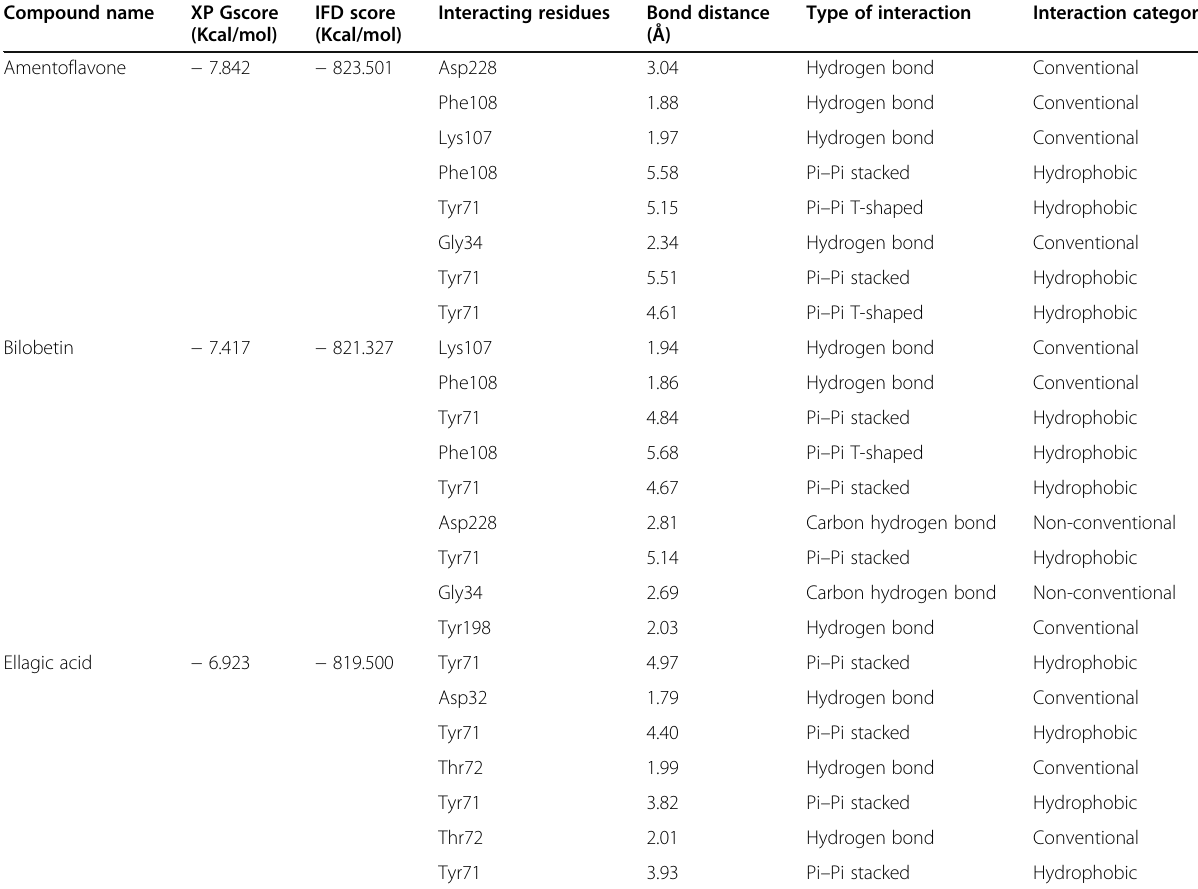
Table 3 Result of best-performed ligand molecules in the IFD experiment, type of interactions, interacting amino acids, and bond